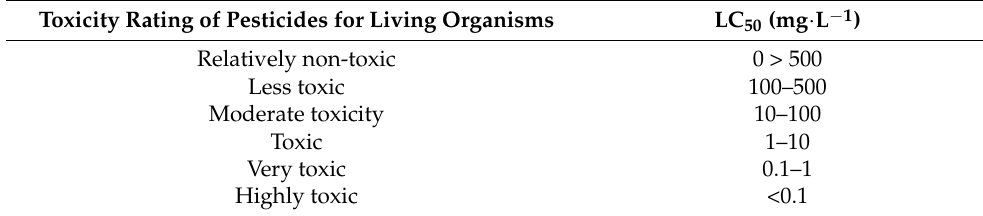
Table 5. Toxicity ratings of pesticides in living organisms according to the U.S. EPA [52]. Toxicity Rating of Pesticides for Living